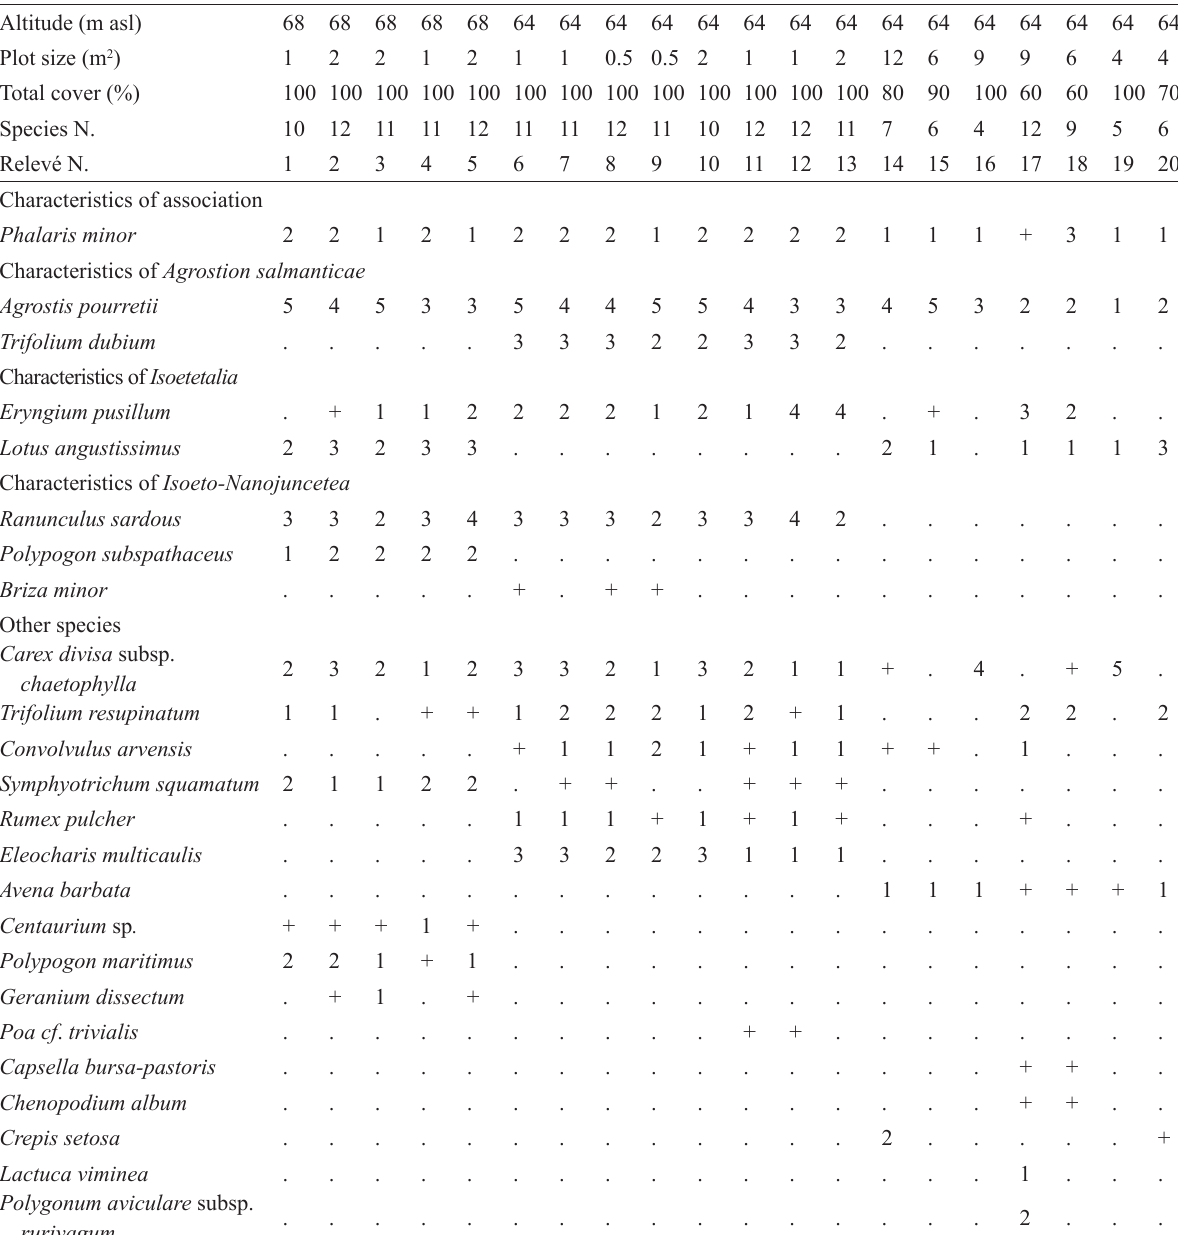
Table 8. Phalarido minoris-Agrostidetum pourretii ass. nova ( Agrostion salmanticae , Isoetetalia , Isoeto-Nanojuncetea ) Altitude (m asl) Plot size (m 2 ) 1 Total cover (%) Species N. Relevé N. 1 2 Characteristics of association Phalaris minor Characteristics of Agrostion salmanticae Agrostis pourretii Trifolium dubium Characteristics of Isoetetalia Eryngium pusillum . Lotus angustissimus Characteristics of Isoeto-Nanojuncetea Ranunculus sardous Polypogon